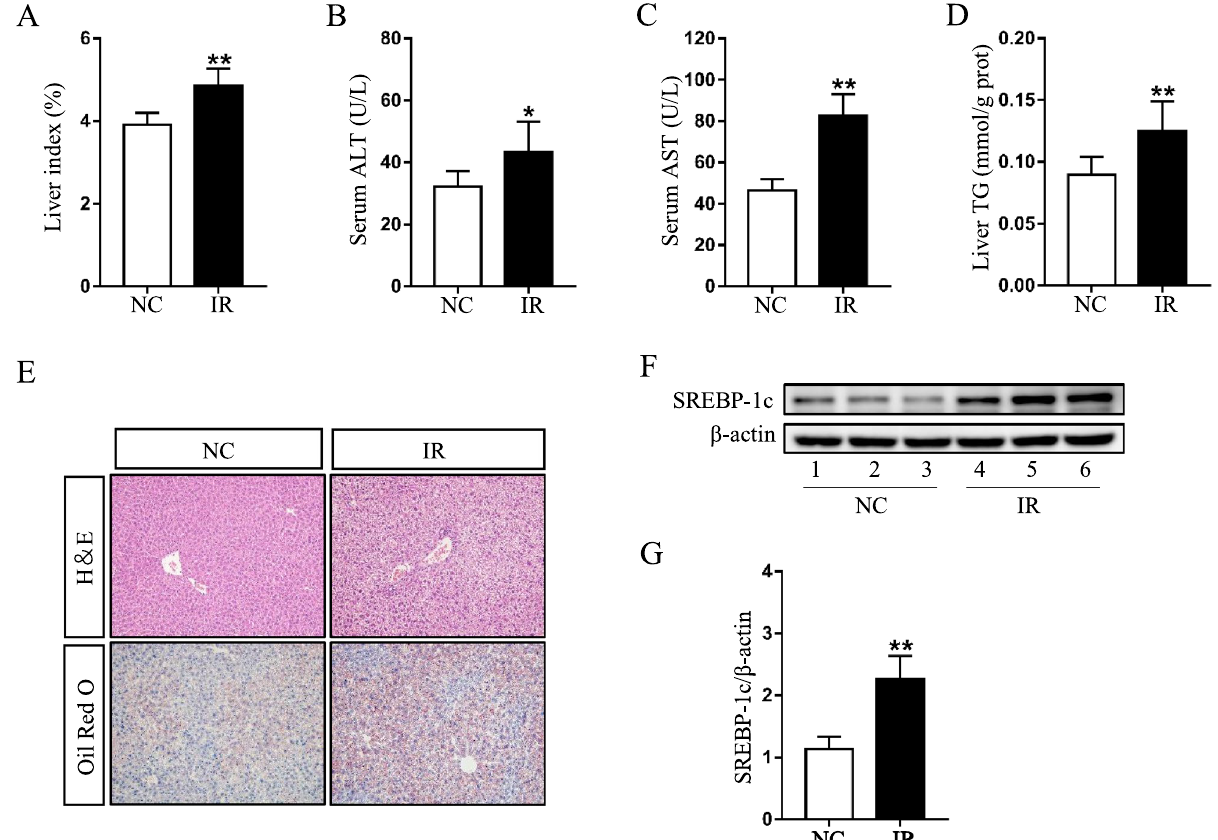
Figure 1. Irinotecan (IR) induces liver injury in mice. Mice were intraperitoneally injected with IR (50 mg/ kg) or solvent (saline) every three days for 3 weeks. Effects of IR on ( A ) liver index, serum levels of ( B ) ALT and ( C ) AST, and ( D ) hepatic TG content. Data are presented as mean ± SD (n = 8), * P < 0.05 and ** P < 0.01 compared with normal control (NC) group. ( E ) Liver sections were stained with H&E and Oil Red O to evaluate lipid accumulation. ( F ) Western blot analysis of SREBP-1c protein level in liver tissue. ( G ) Densitometric quantification of SREBP-1c. The blots were cut prior to hybridisation with indicated primary antibodies. Data are presented as mean ± SD (n = 6), ** P < 0.01 compared with NC